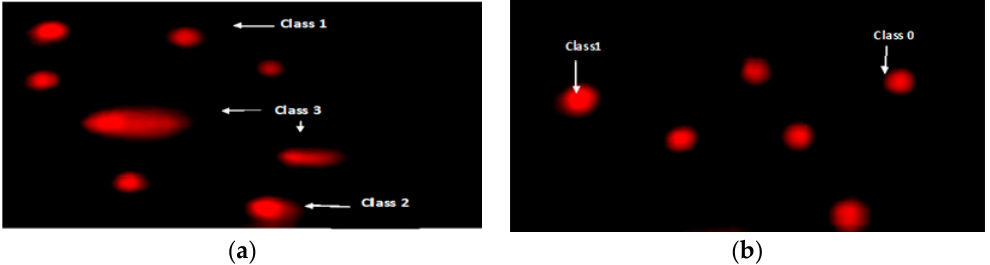
Figure 4. Comet assay in liver tissues shows visual DNA damage score: ( a ) classes 1, 2 and 3, ( b ) class 0 and 1.